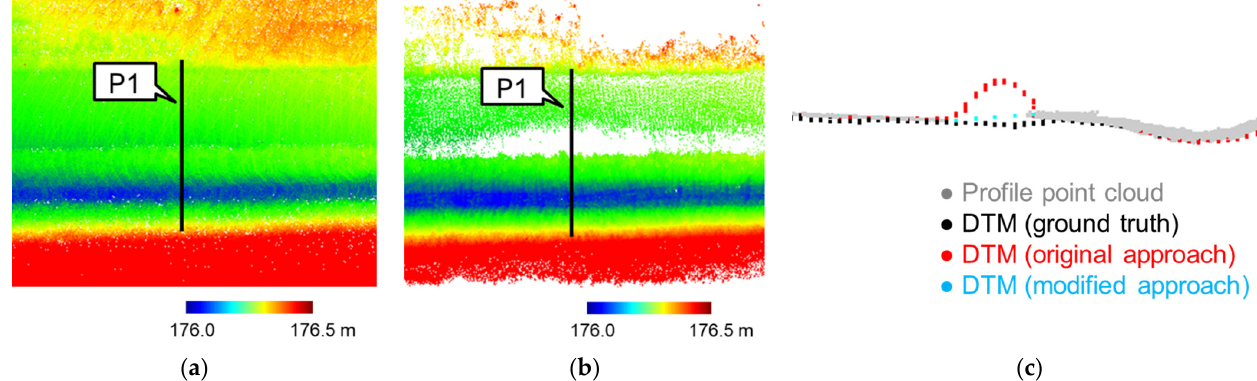
Figure 6. Comparison between the original and modified approaches for digital terrain model (DTM) generation: ( a ) point cloud from PWMMS-HA, ( b ) point cloud from UGV, and ( c ) side view of profile P1 showing point cloud, ground truth DTM, and DTM based on the original and modified approaches.